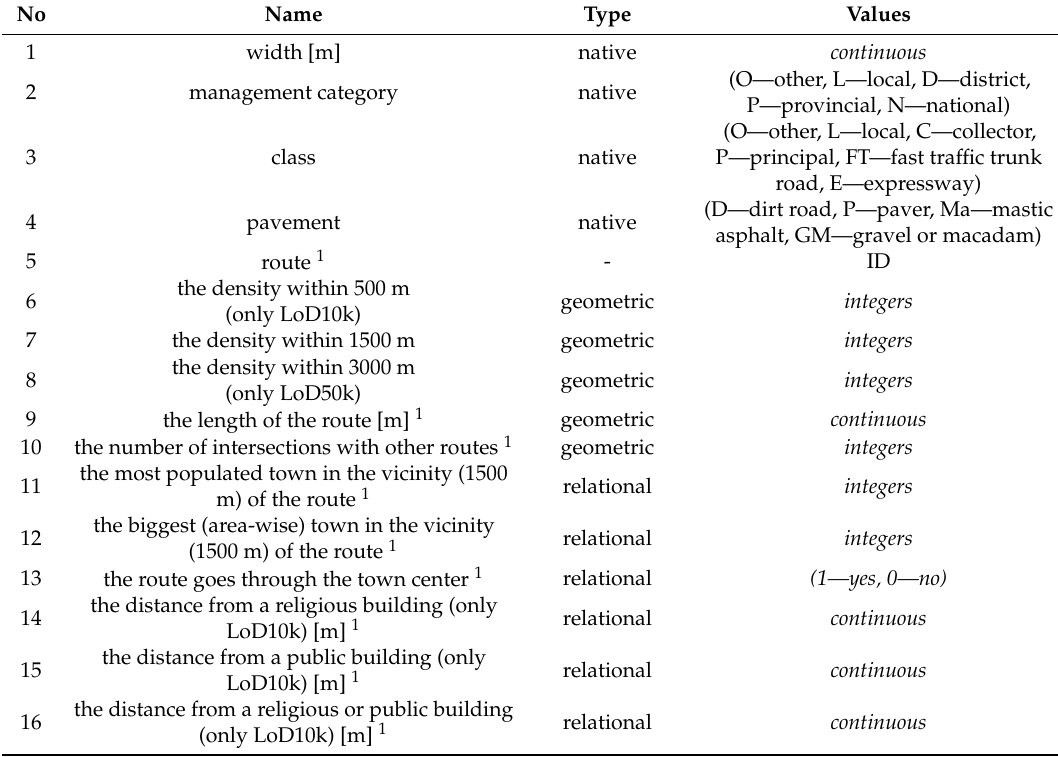
Table 4. Attributes of sections of roads in model data along with the indication of the types of attributes and their values; source: own work.